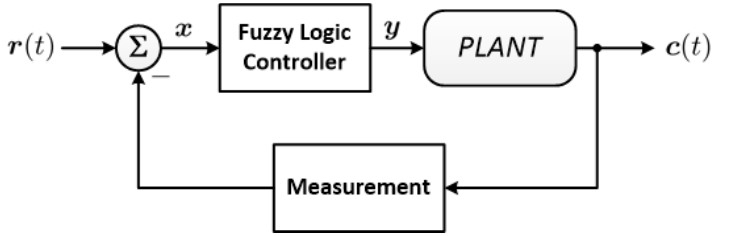
Figure 3. Block diagram for an FLC used in direct form. The input signals, x , to the FLC are the errors obatined from the summation point, and their outputs, y are the control signals to the plant. From inside, an FLC can be represented in a general form, as in [21] Figure 4.